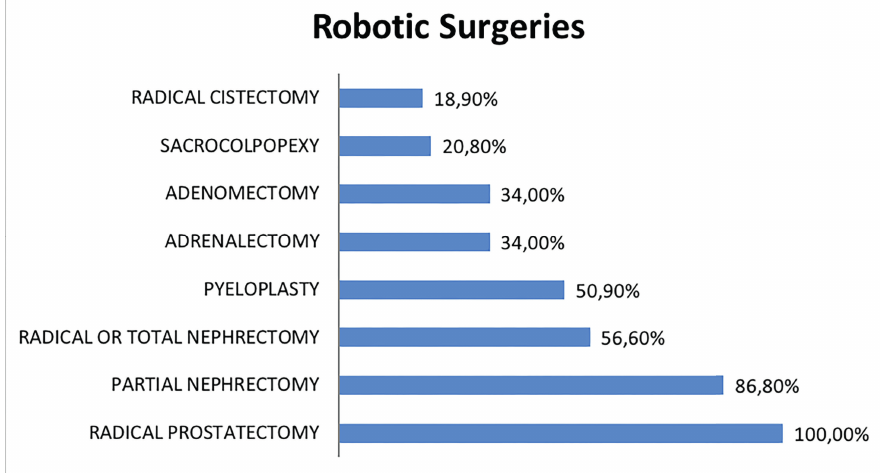
Figure 2 - Surgeries performed by robotic